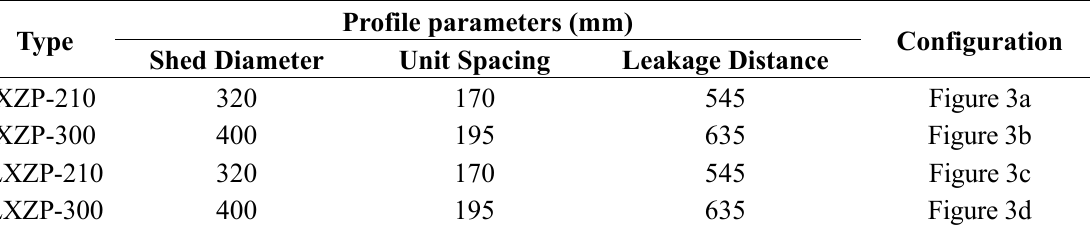
Table 1. Parameters of porcelain and glass insulators.